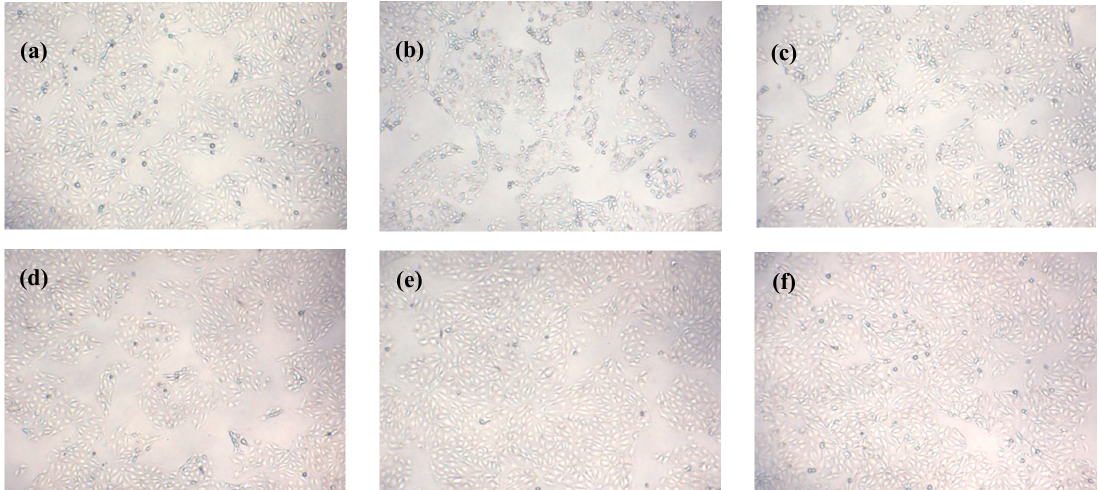
Figure 4. Effects of Que on morphology of IPEC-J2 exposure to H 2 O 2 . IPEC-J2 were pre-treated with